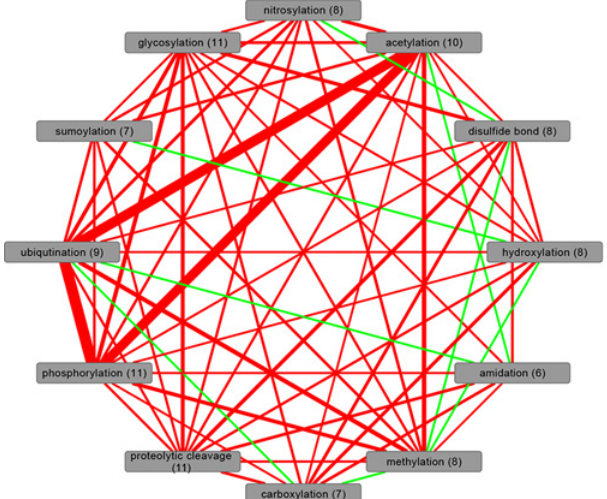
Figure 2. Co-existence network of PTM-types in the proteome of Homo sapiens . Nodes represent the protein sets associated with the different PTM-types. Edge width was set proportionally to the Jaccard index indicating the overlap between the different protein sets. Edge colors indicate significance with red highlighting PTM-pairs whose overlap was found significant based on Fisher ’ s exact test with FDR-adjusted p -value threshold set to 0.01, and green otherwise. Numbers in parentheses are the counts of significant “ red ” co-existence edges to other PTM-types.